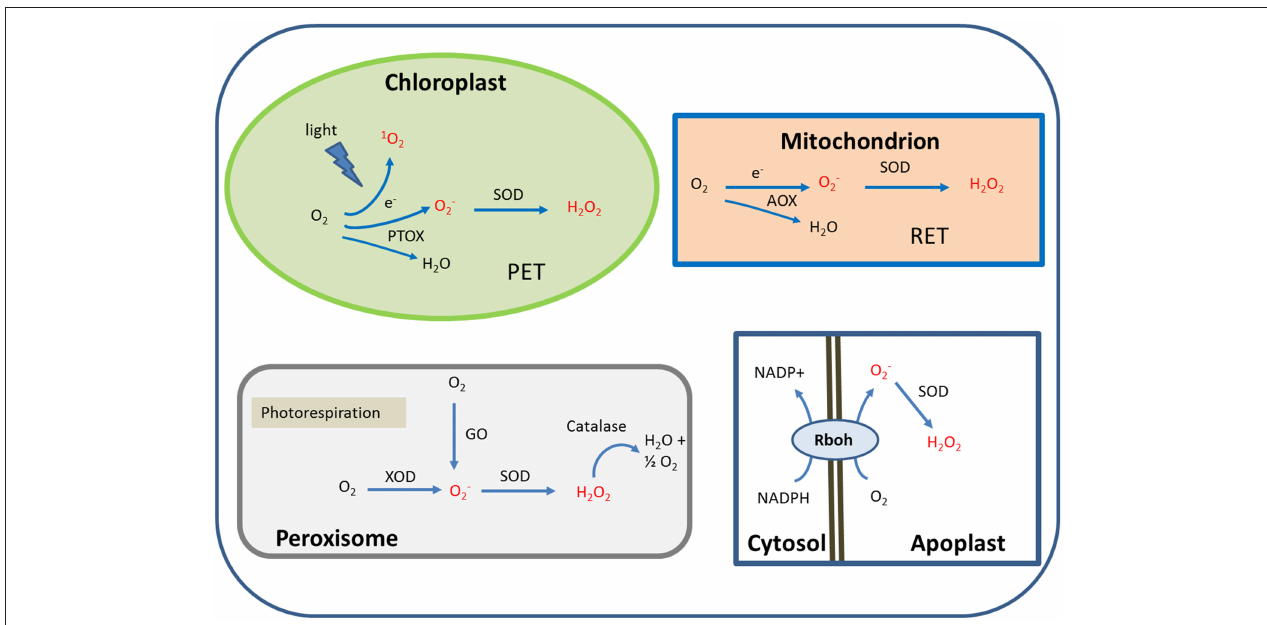
FIGURE 2 | Simplified scheme illustrating the predominant ROS generation sites in plant cell under salinity stress. These sites are photosynthesis in chloroplasts, respiration in mitochondria, photorespiration in peroxisomes and NADH oxidation at the plasma membrane. AOX, alternative oxidase; GO, glycolate oxidase; PET, photosynthetic electron transport; PTOX, plastid terminal oxidase; RBOH, respiratory burst oxidase homolog; RET, respiratory electron transport; SOD, superoxide dismutase; XOD, xanthine oxidase.